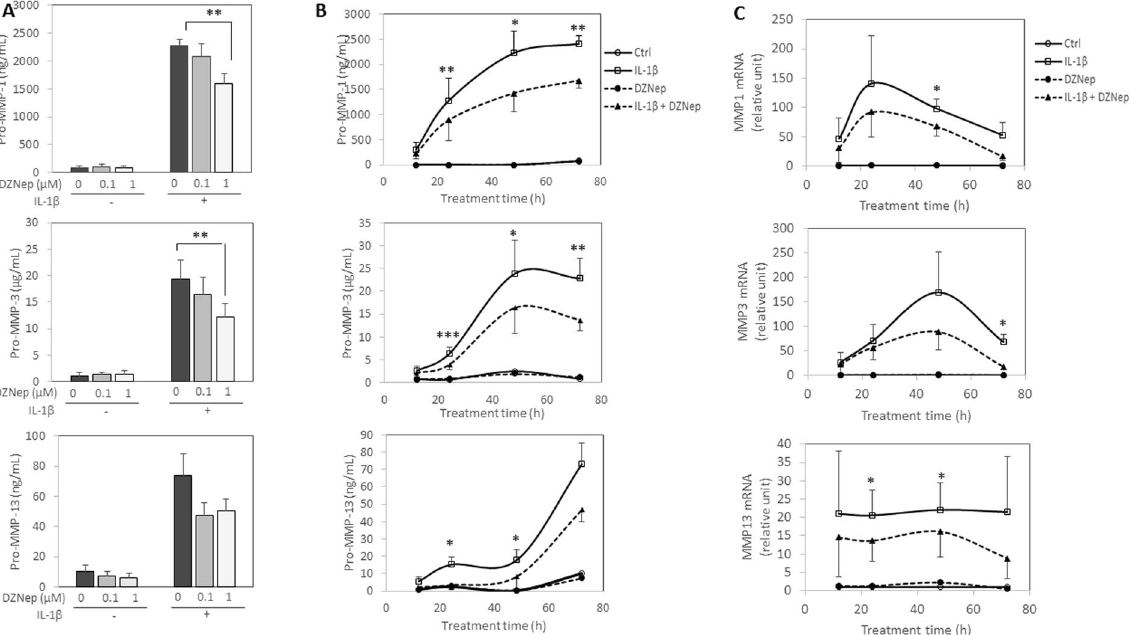
Figure 3. DZNep reduced MMP release and mRNA expression of MMPs induced by IL-1 β . ( A ) Primary chondrocytes were treated or not with DZNep (0 µ M, 0.1 µ M or 1 µ M) in the presence or absence of IL-1 β (1 ng/ mL) for 72 h. ( B – C ) Primary chondrocytes were treated or not with DZNep (1 µ M) in the presence or absence of IL-1 β (1 ng/mL) for 12 h, 24 h, 48 h or 72 h. After treatment, protein levels of MMP-1, MMP-3 and MMP- 13 were determined in culture medium by ELISA assay ( B ). RNA was also extracted, and relative expression of MMP-1 , MMP-3 and MMP-13 were determined in cells by real-time RT-PCR, using GAPDH expression as reference ( C ). Data are expressed as means ± SEM. Statistical significance between “IL-1 β ” and “IL- 1 β + DZNep” conditions are represented. * p-value ≤ 0.05; ** p-value ≤ 0.01; *** p-value ≤